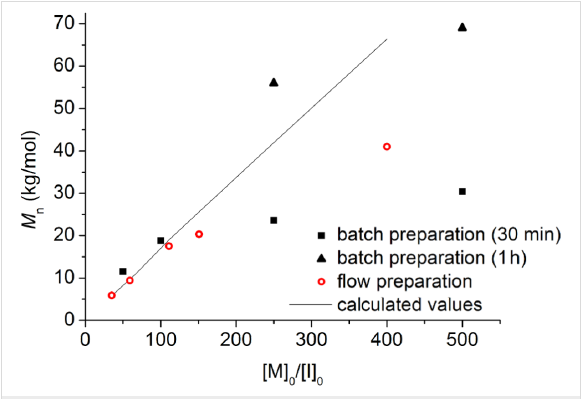
Figure 3: Plot of number-average molecular weight, M n , versus mono- mer–catalyst ratio [M] 0 /[I] 0 for batch and flow samples prepared